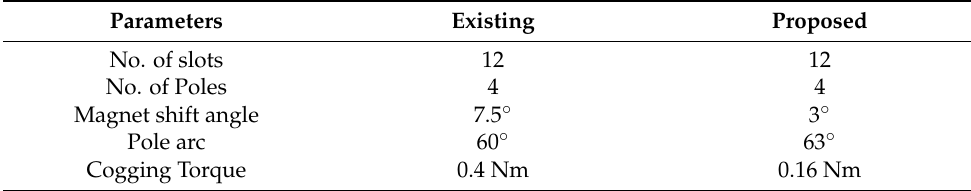
Table 8. Comparative results of the existing and proposed